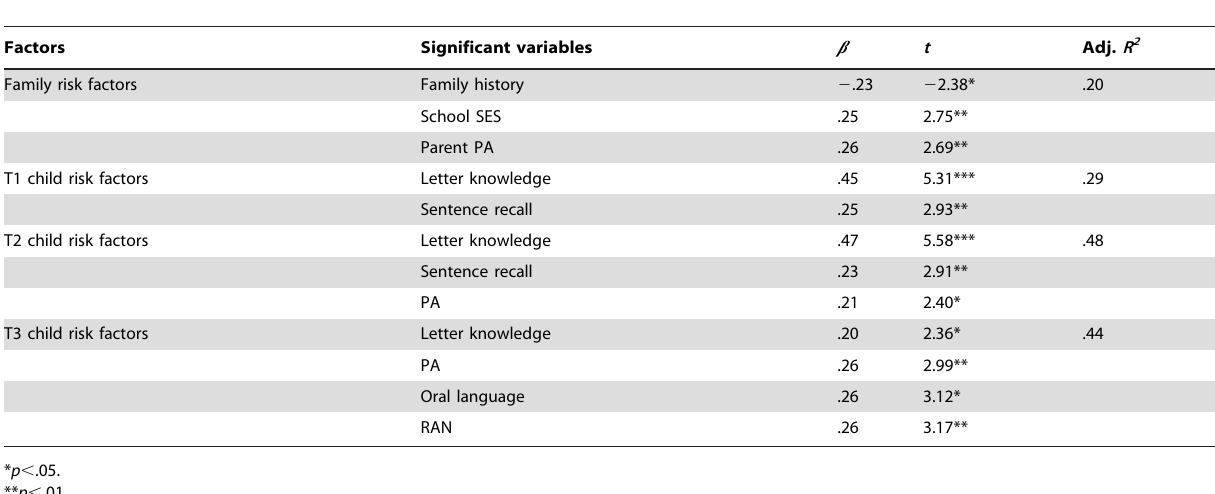
Table 4. Family risk factors and child risk factors at T1, T2 and T3 that were significant (stepwise regressions for each factor set) in predicting early Year 1 literacy